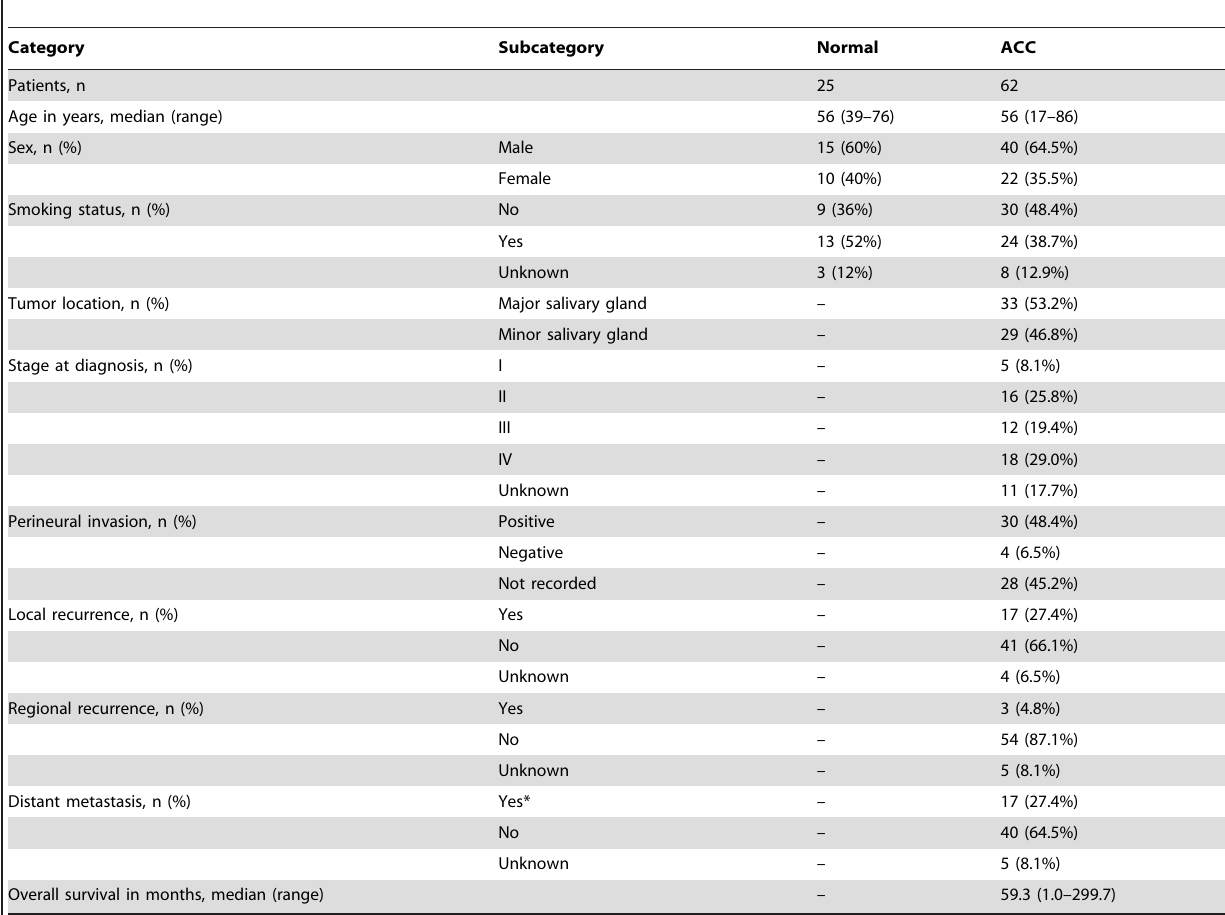
Table 1. Clinical and pathologic characteristics of patient